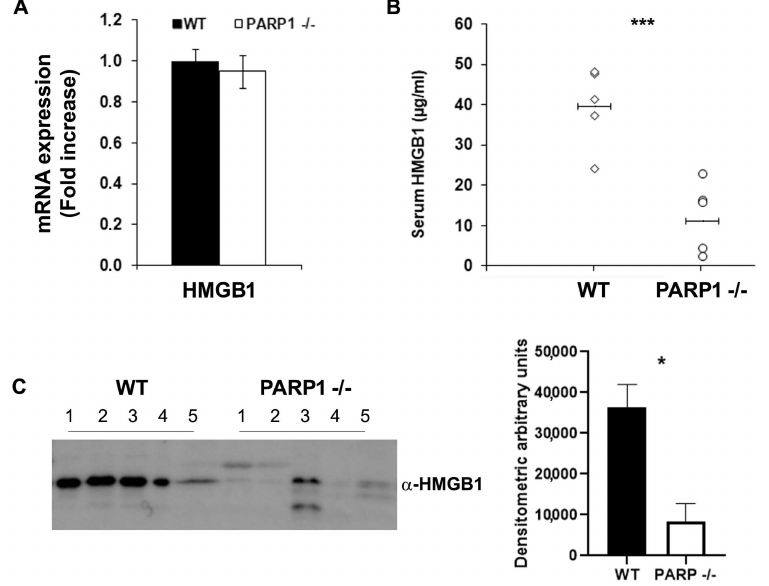
Figure 2. The release of HMGB1 in the stools and serum of PARP1 − / − mice is significantly decreased compared to WT mice (5 animals per group). Analysis of intracellular ( A ), serum ( B ) and fecal ( C ) HMGB1 in PARP1 − / − and WT mice treated with 3% DSS. Statistical analysis was performed using the Mann–Whitney U test. * p < 0.05; *** p <